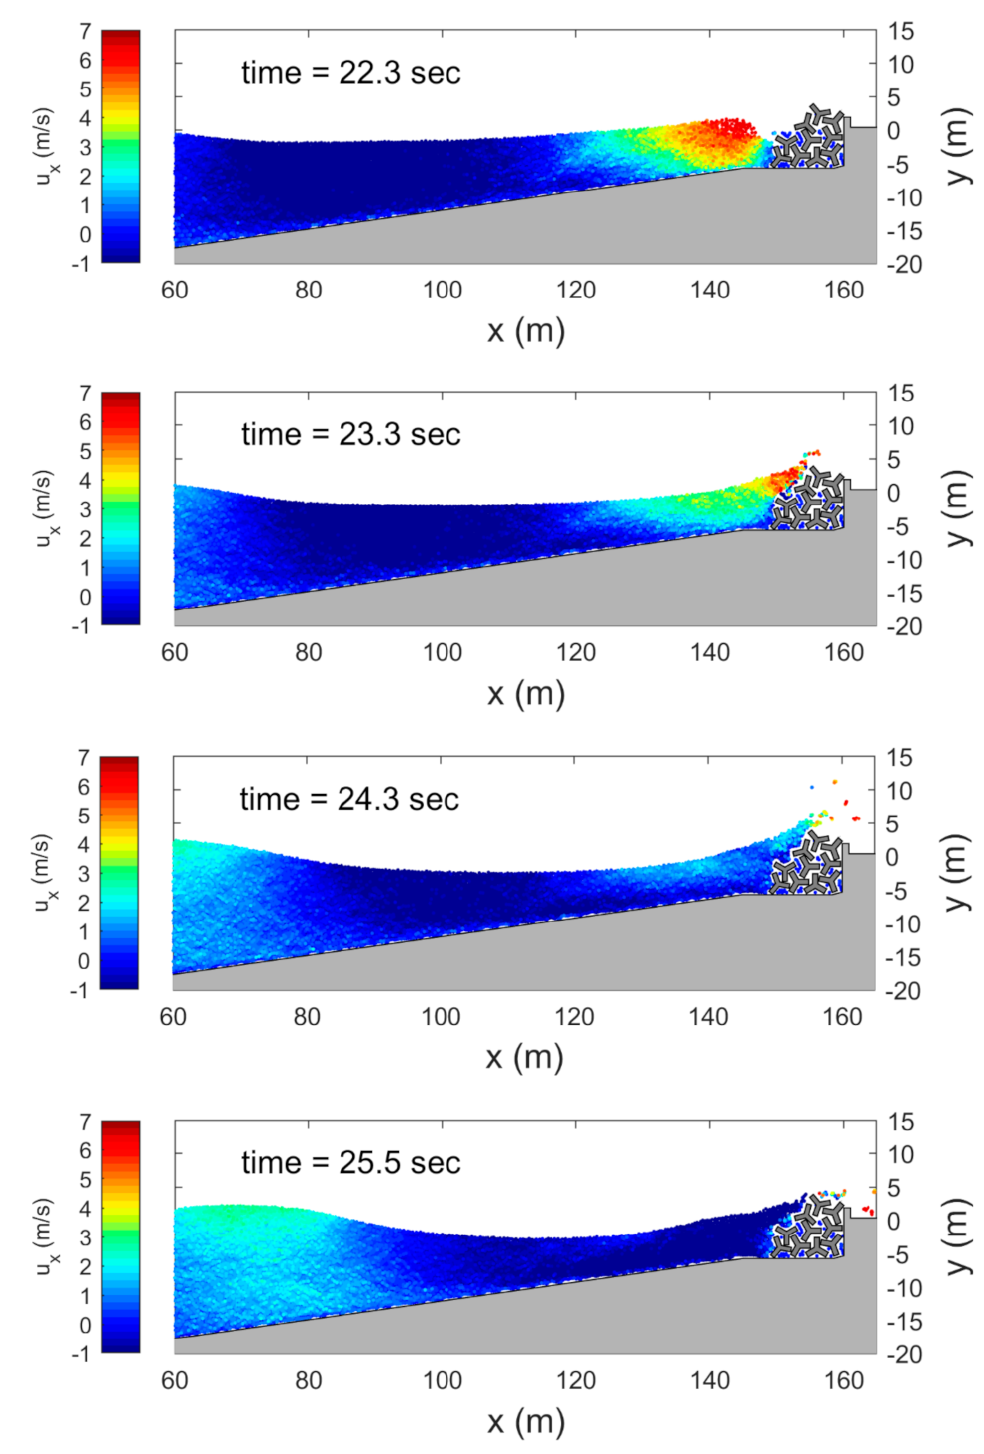
Figure 10. Simulation results with armor blocks (case A3; H = 4.5 m, T = 12